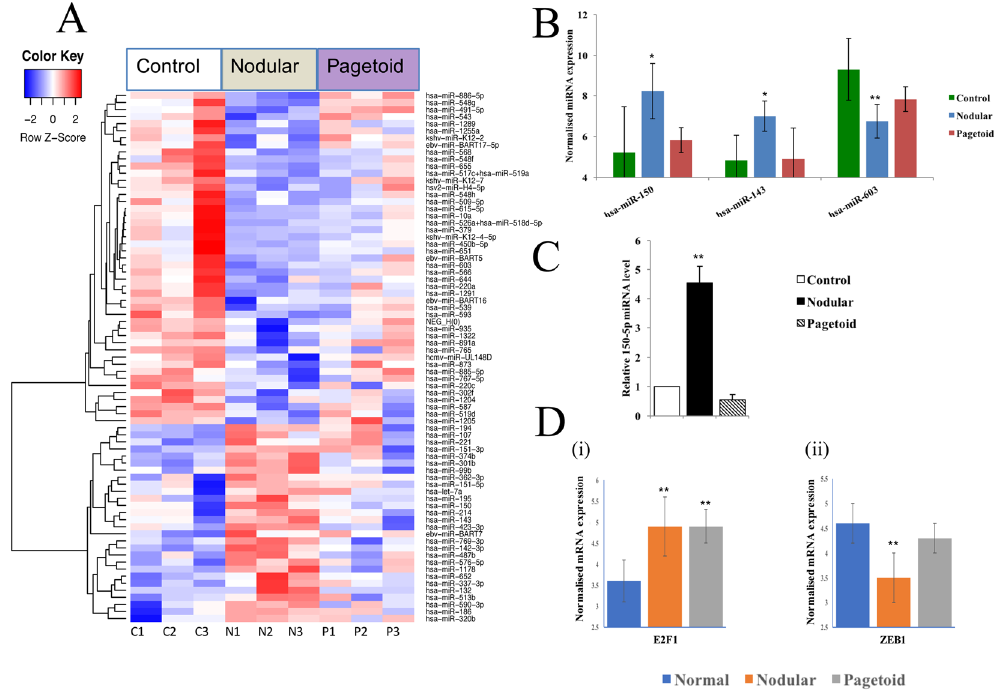
Figure 2. Nodular sebaceous gland carcinoma specific microRNAs. ( A ) Seventy-five significant differentially expressed microRNA unique to nodular SGC using a p < 0.05 threshold. ( B ) Top 3 differentially expressed miRNAs present in nodular SGC only when compared to tarsal plate control. Pagetoid expression shown to demonstrate non-significant change within the subtype. ( C ) MicroRNA verification of 150-5p expression using Taqman RT-qPCR in SGC. Relative expression levels were determined for nodular and pagetoid SGC using Taqman RT-qPCR against normal eyelid tissue for miRNA 150-5p. ( D ) Expression of target genes in nodular and pagetoid subtype for hsa-miR-150-5p. Significance levels are shown as * P < 0.05, ** P < 0.01, *** P < 0.001. Error bars represent mean + / −